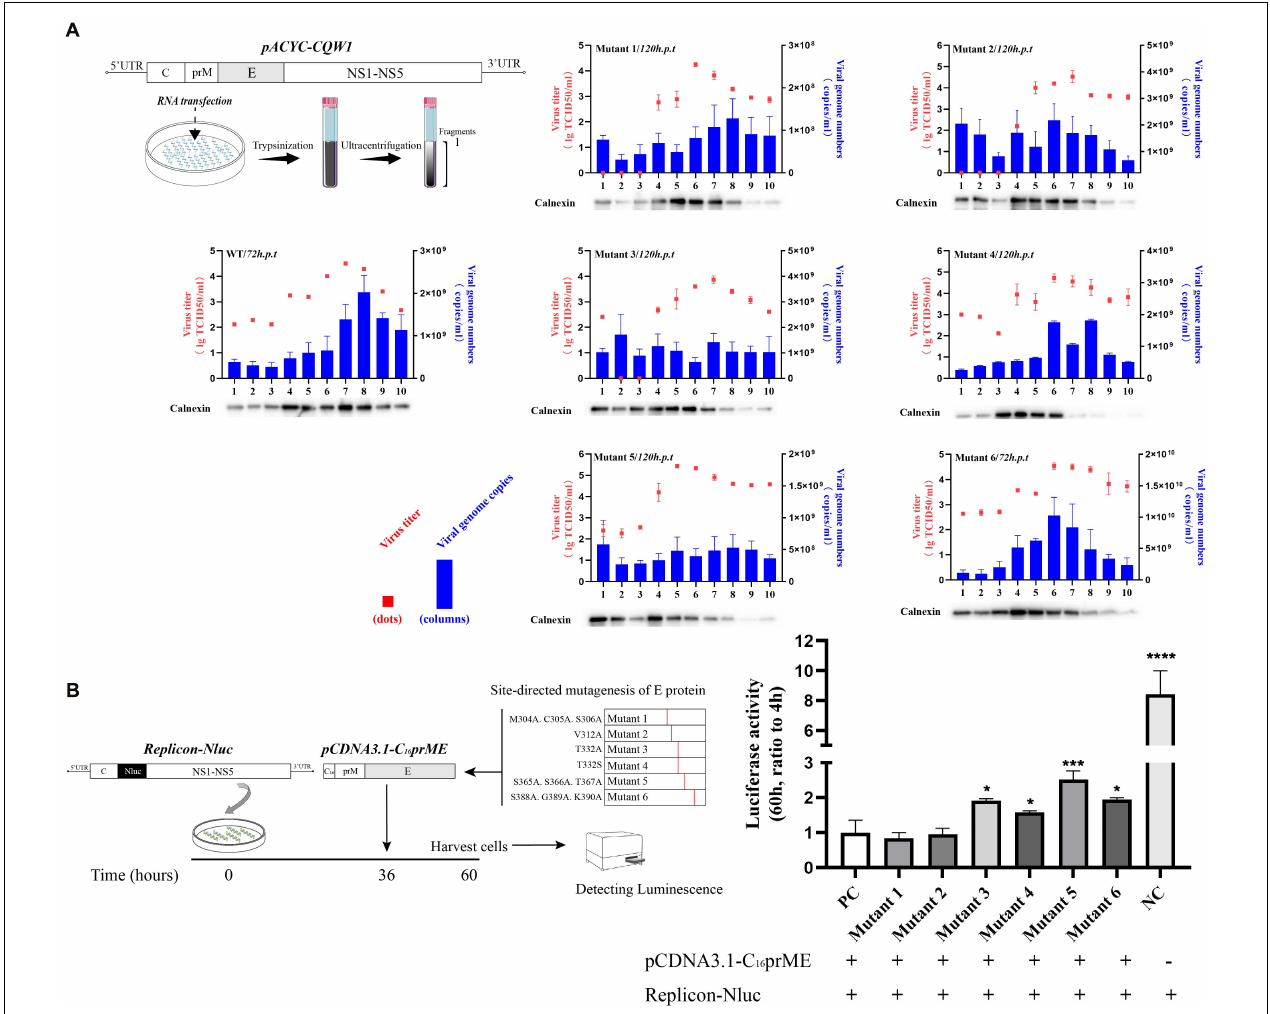
FIGURE 5 | Subcellular fractionation of in vitro -transcribed genomic RNA-transfected BHK-21 cells and packaging system assay. (A) Schematic diagram for the subcellular fractionation assay (left panel). The cellular contents were analyzed by fractionation on an iodixanol gradient. Ten fractions were collected from the top of the gradient, and the individual fractions were titrated by TCID 50 (red dots). The blue columns represent the distribution of infectious virus in the fractions collected from cells transfected with Tembusu virus (TMUV) RNA. Each fraction was also chloroform/methanol precipitated and analyzed by Western blot (WB) for the presence of calnexin. (B) Schematic diagram for the packaging system assay (left panel). The relative luciferase activity is represented by the Nluc level at 60 h post-transfection relative to 4 h post-transfection. The Nluc levels of all mutants are shown as relative ratios to wild type (WT). PC: WT pCDNA3.1-C 16 prME, NC: replicon-Nluc only (right panel). Means and standard errors are from three independent experiments. Asterisks denote a statistically significant difference in viral assembly compared to that of the WT. * p ≤ 0.05; ** p ≤ 0.005; *** p ≤ 0.001; **** p ≤